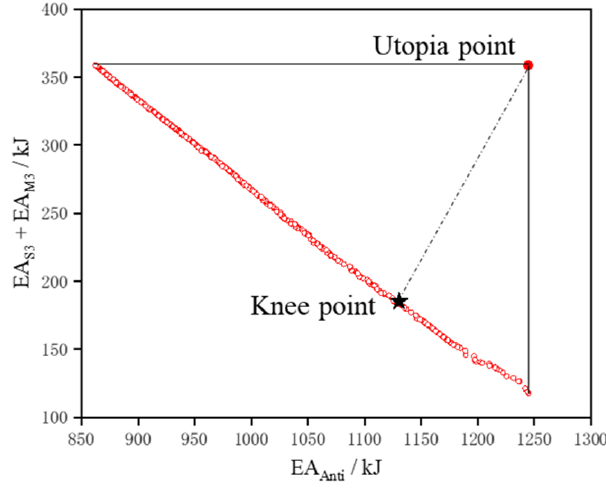
Figure 24. Pareto frontier and optimal scheme of multi-objective optimization. In this formula, D is the distance from the optimal solution (knee point) to the ideal point (utopia point), f in is the value of the objective function n corresponding to the i th solution in the Pareto solution set and M is the number of objective functions.